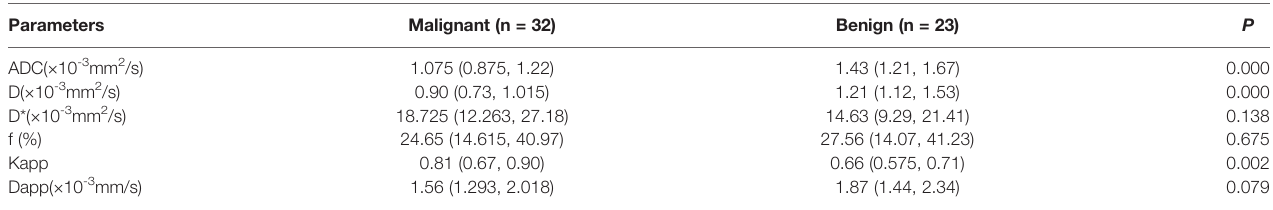
TABLE 2 | The differences of ADC, IVIM and DKI parameters between malignant and benign lesions.